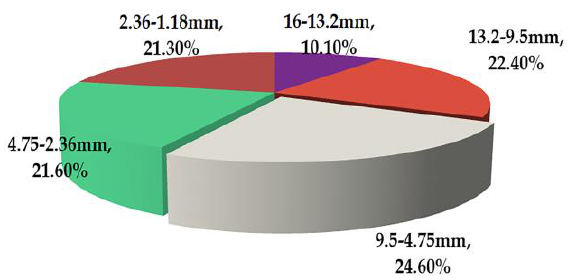
ff erent sizes for rutting